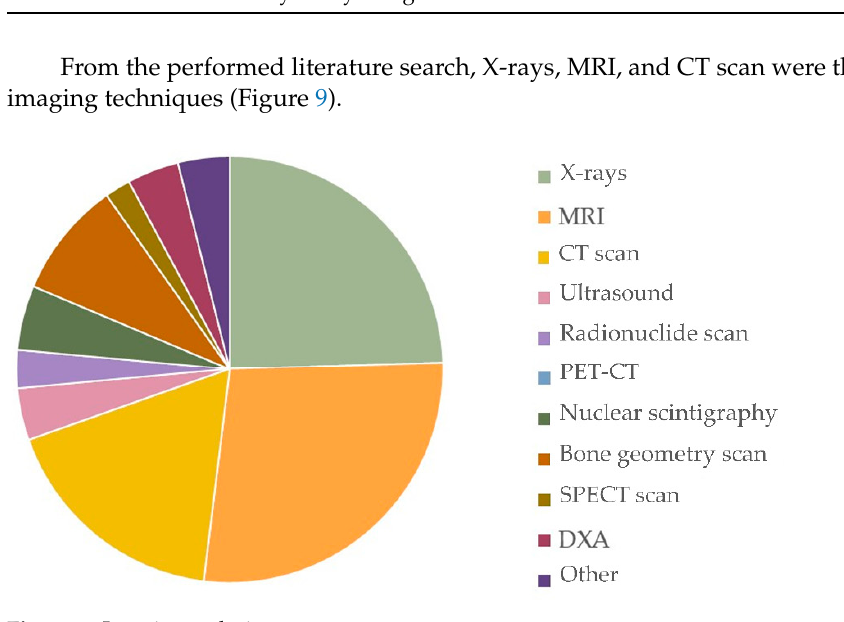
Figure 9. Imaging techniques.